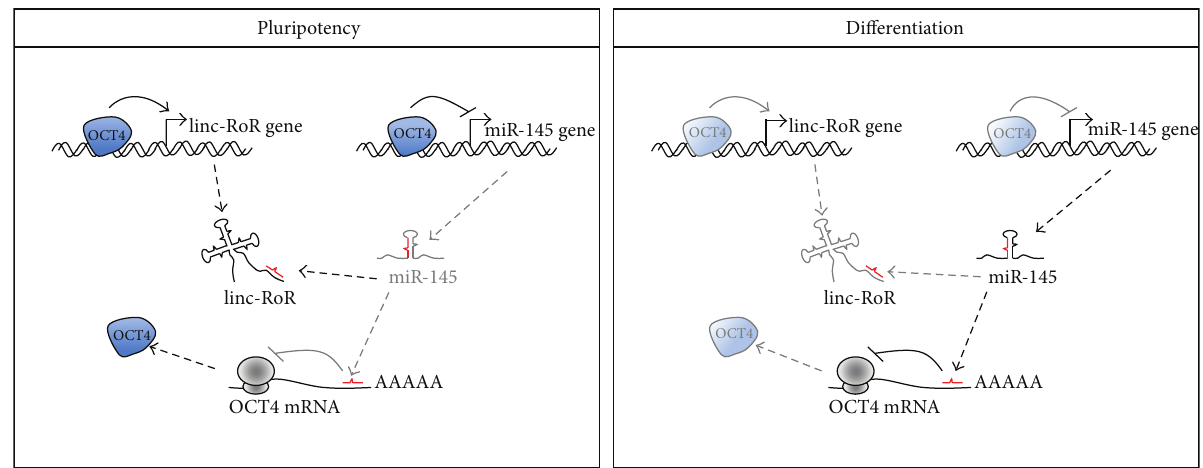
Figure 2: linc-RoR as a paradigm for lncRNA regulation of pluripotency in the cytoplasm. In pluripotent cells, the levels of linc-RoR are controlled by OCT4. In a positive feedback loop, linc-RoR sponges miR-145, thus derepressing its targets, including OCT4. OCT4 also negatively controls miR-145 at the transcriptional level [41, 59–61]. See text for details.